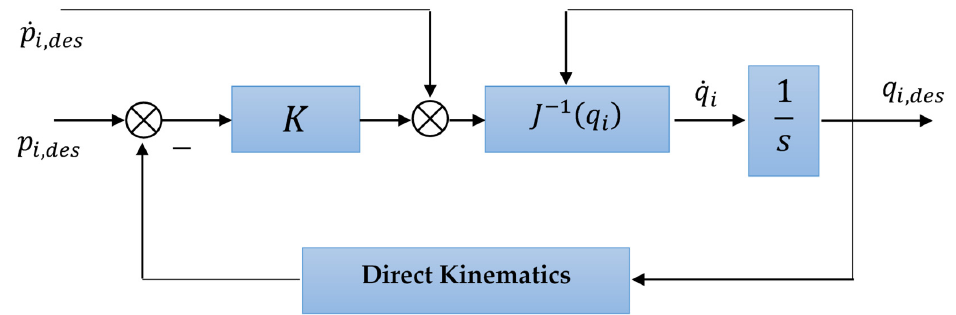
Figure 3. Schematic representation of the kinematic control.